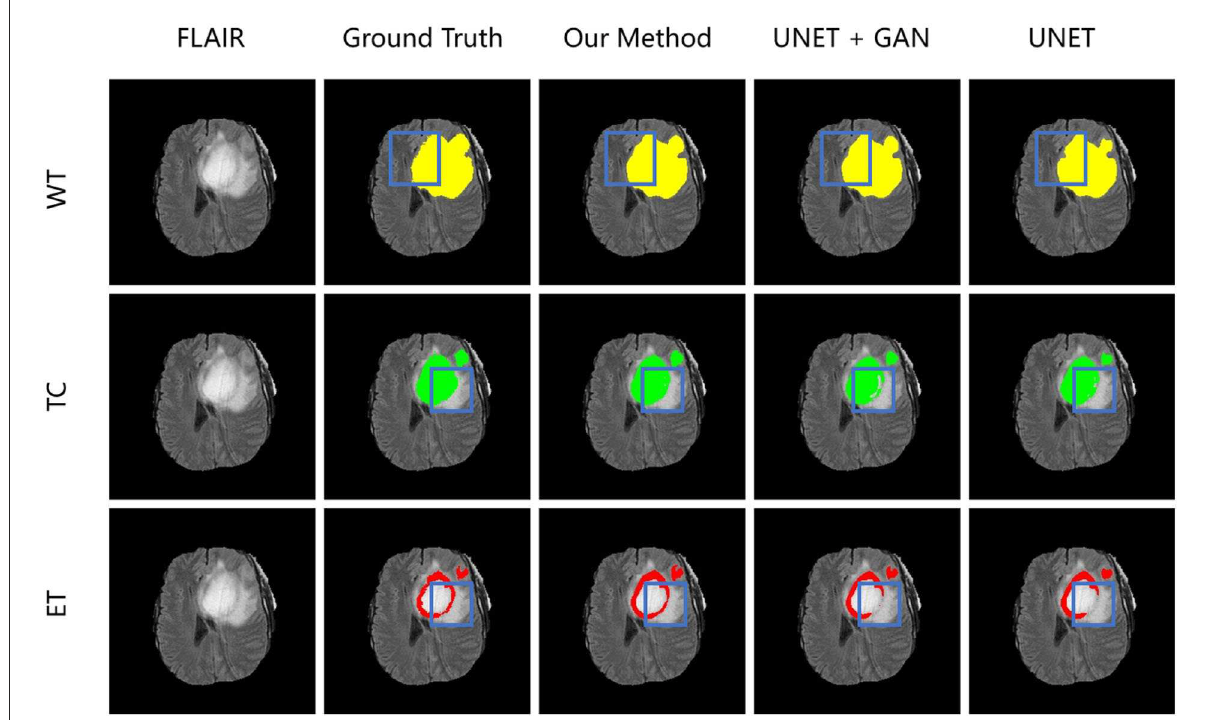
FIGURE6 From left to right is the visualization results of an original image in FLAIR modality, ground truth, model in our method, model in the form of UNET + GAN, model UNET. From up to down in each column is three segmentation maps predicted with the same method. The blue boxes outline the difference between results from different